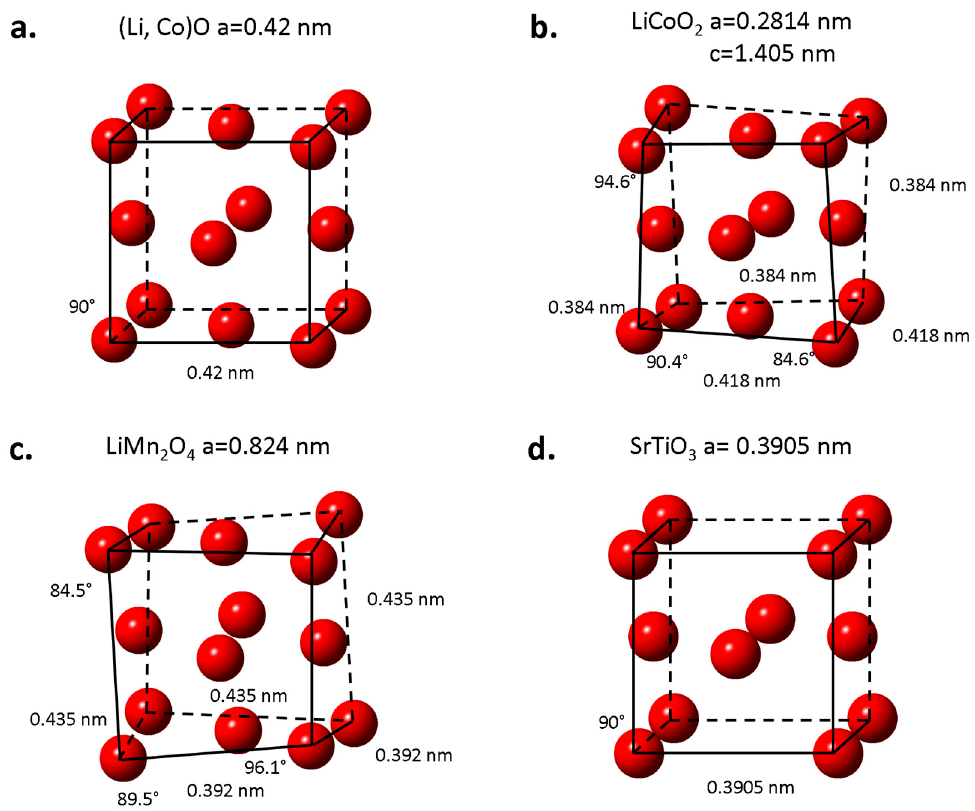
Figure 2. A face-center cubic oxygen anions sublattice for the rock-salt structure of (Li, Co)O ( a ); and its pseudo-cubic variants for LiCoO 2 ( b ); and LiMn 2 O 4 ( c ). Oxygen anion sublattice for perovskite SrTiO 3 ( d ) showing similarity (the depicted unit cell is shifted [½ ½ 0] from the origin of the STO cell), and thus the capability for cube-on-cube growth of different cathode films on perovskites.